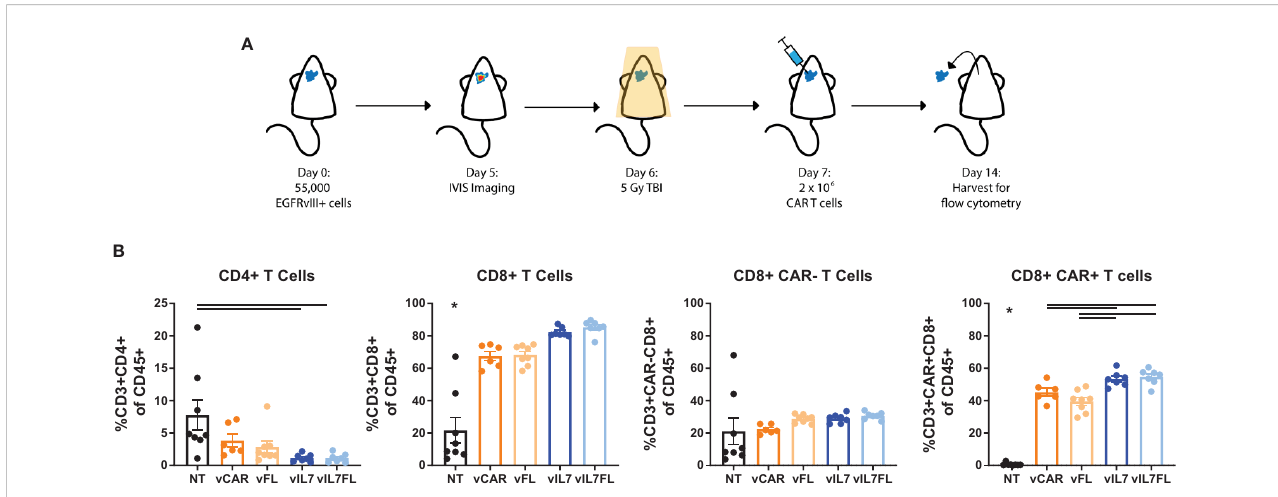
FIGURE 2 IL7 and IL7 Flt3L co-expressing CAR T cells increased the CD8 CAR T cell population in a 5 Gy TBI EGFRvIII homogenous model. (A) Experimental timeline. Animals were inoculated intracranially with 55,000 vIII tumor cells. Tumors were IVIS imaged fi ve days later and subjected to 5 Gy irradiation on day 6. On day 7, 2x10^6 CAR T cells were injected intracranially. (B) The tumor was harvested for fl ow cytometry on day 14 and analyzed for T cell populations (n=6-8). A one-way ANOVA with a Tukey ’ s multiple comparison test determined signi fi cance. Mean and SEM are plotted. * = denotes signi fi cance compared to all other